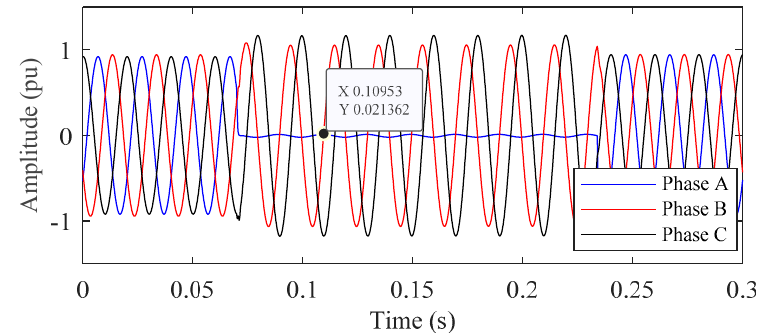
Figure 14. Voltage sag when phase A to ground fault occurs at F.2. Figure 15. Voltage sag when phase A to ground fault occurs at F.2. TvHFA ; ( c ) FvA.